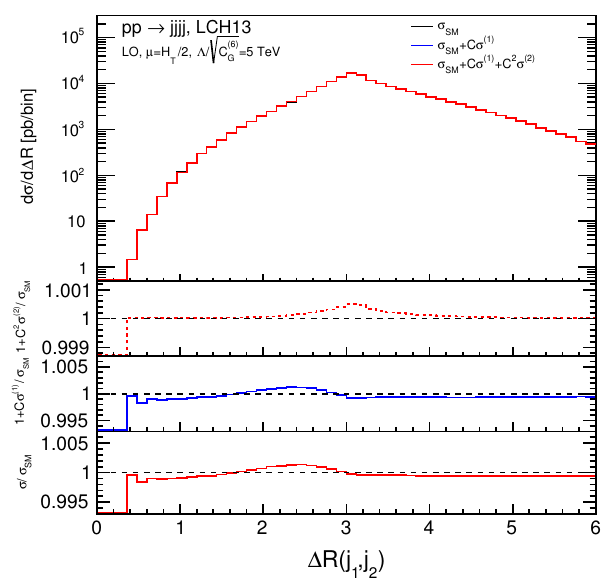
p Figure 7 . Angular separation (cid:1) R = (cid:1) (cid:30) 2 + (cid:1) (cid:17) 2 between the two leading partonic jets in 4-jet production, for the SM and the signal of order O (1 = (cid:3) 2 ) and O (1 = (cid:3) 4 ), in the presence of the cuts S T >2 TeV, (cid:1) R > 0 : 4 and p T; min > 50 GeV (applied to all jets). In the computation of the result of order O (1 = (cid:3) 4 ), only the contributions from at most one insertion of the operator O G in the amplitudes are considered.